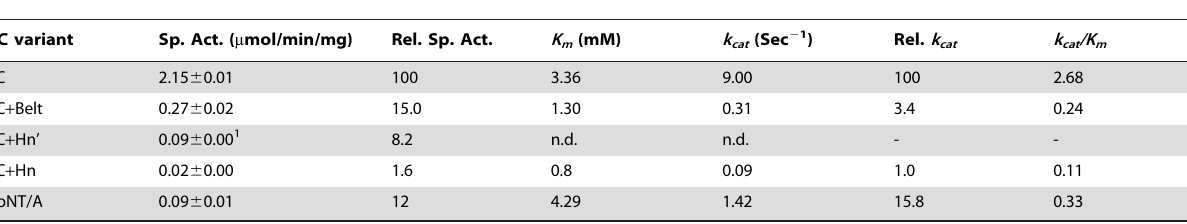
Table 2. Specific activity and kinetic constants of various light chain constructs.